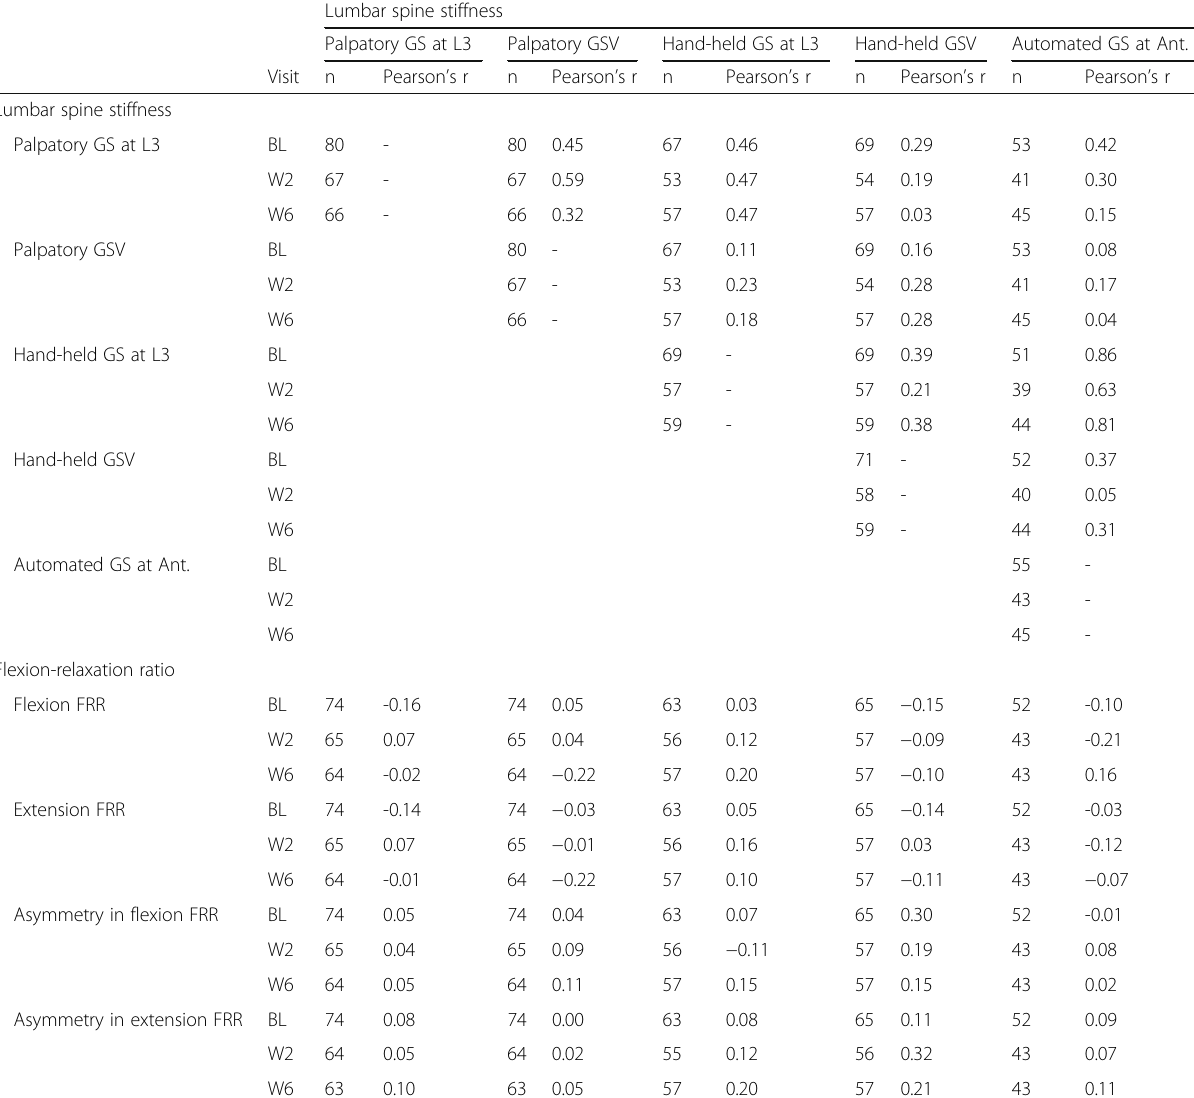
Table 3 Pearson ’ s correlations ( r ) between spine stiffness obtained using 3 methods and flexion-relation